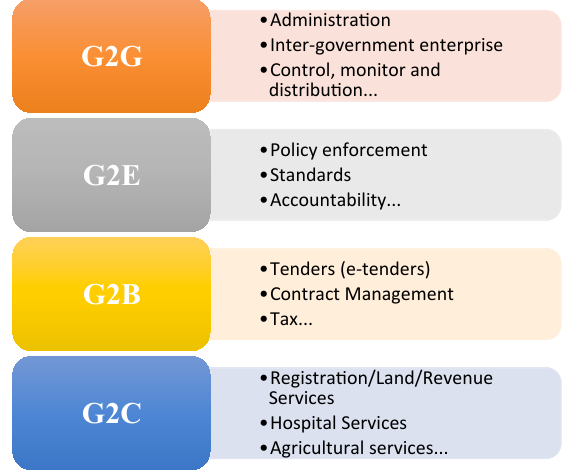
Types of e-Governance application Fig.